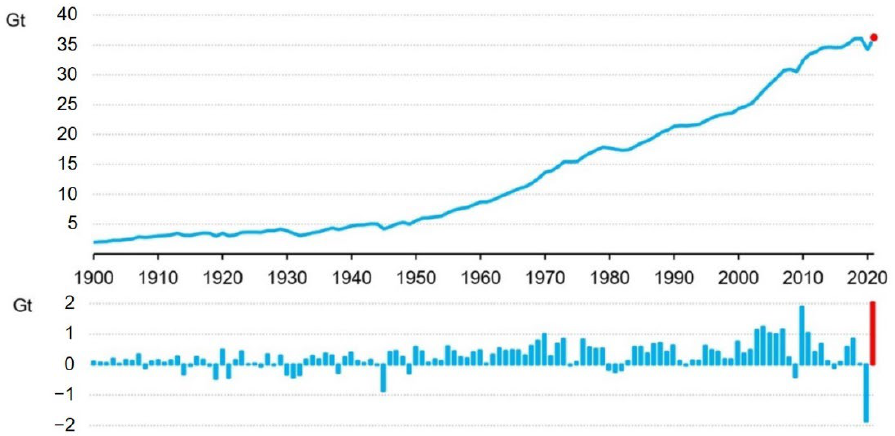
Figure 1. Total CO 2 emissions from energy combustion and industrial processes and their annual change, 1900 – 2021. Reprinted with permission from ref. [1]. Copyright 2022 IEA.